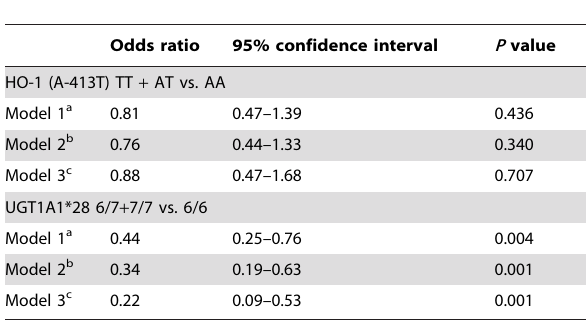
Table 2. Independent risk of recipients with UGT1A1*28 polymorphism 6/7 + 7/7 versus 6/6 of acute rejection analyzed by multivariate logistic